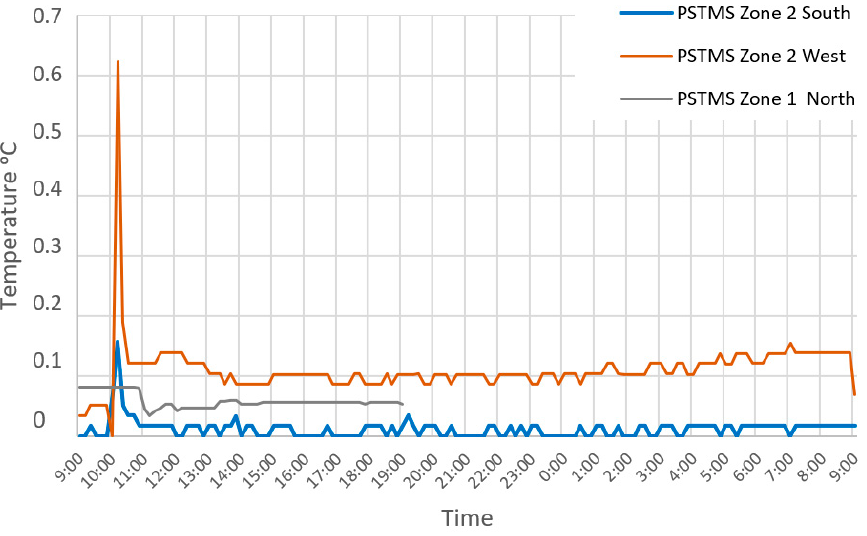
Figure 7. Standard deviation on north, south and west surfaces. North zone on 16 September 2019, and west and south zones on 17 September 2019.